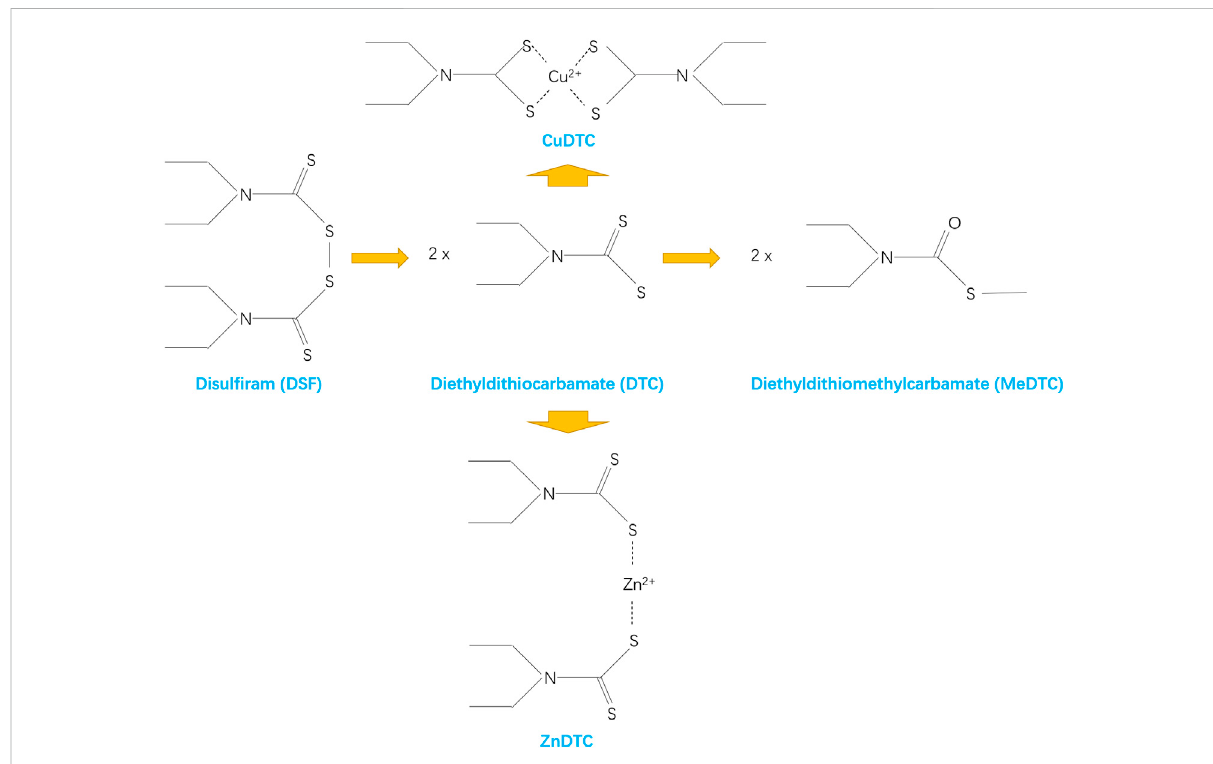
FIGURE 1 Molecular structure of